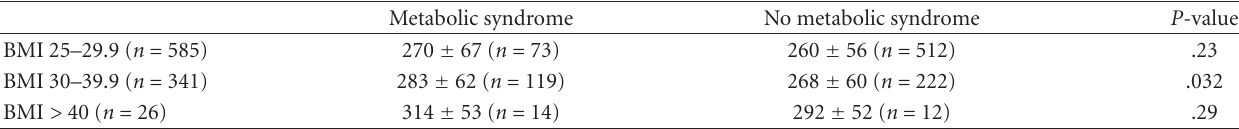
Table 3: Platelet counts in overweight, obese, and morbidly obese females with and without the metabolic syndrome.